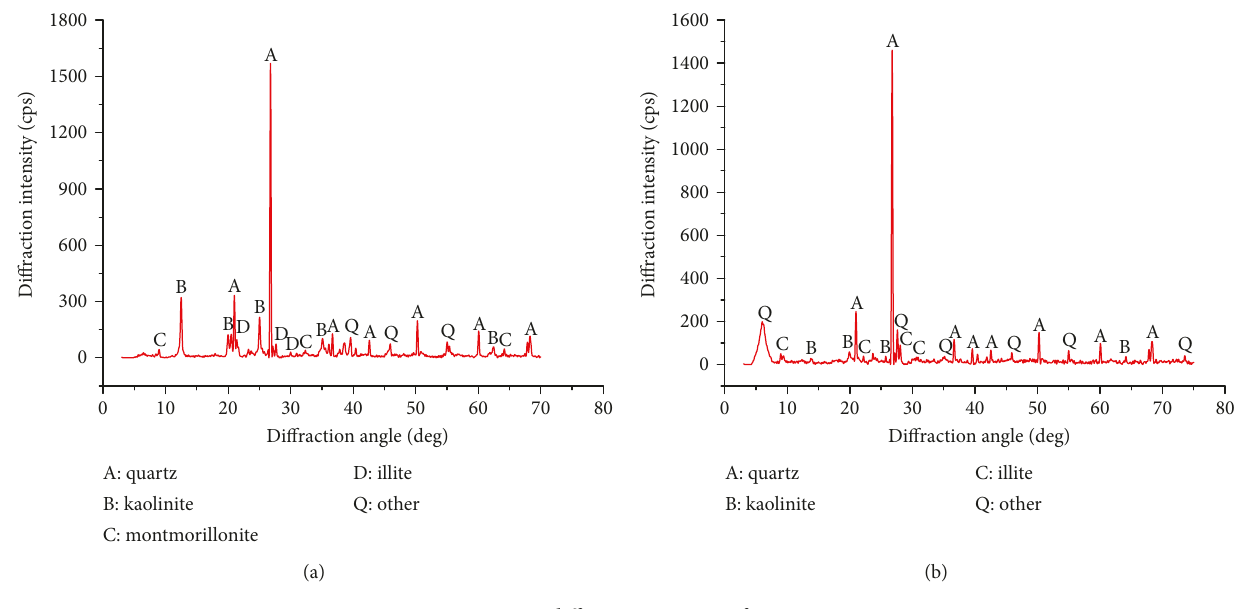
Figure 6: X-ray di ff raction patterns of specimens. Table 4: Results of composition analysis in specimens using